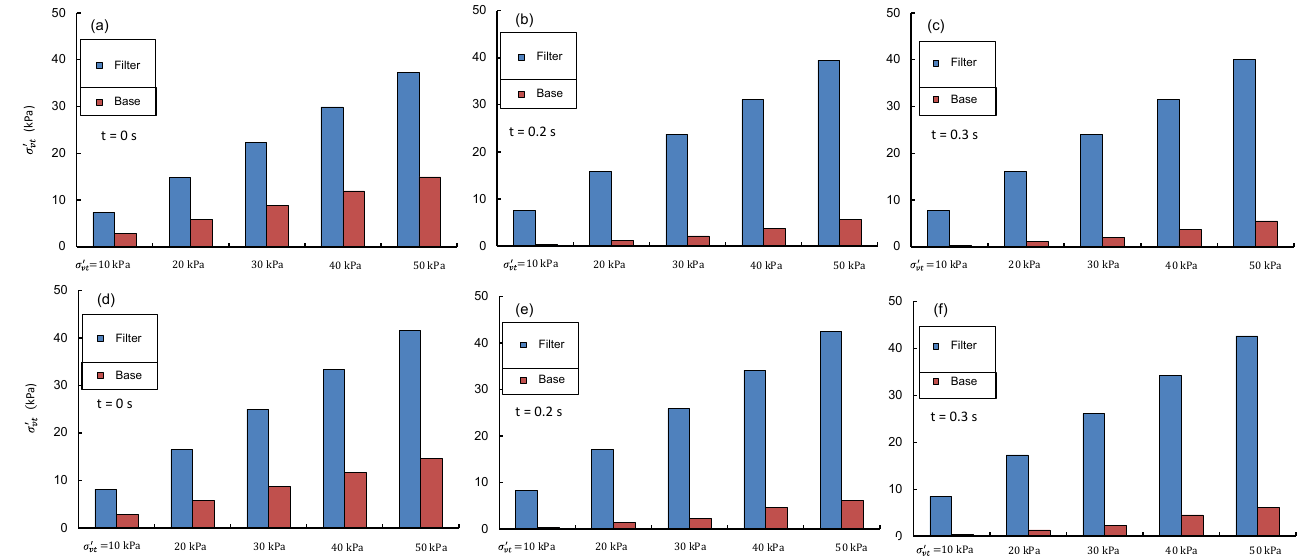
Figure 3. Effective stress distributions in specimens; ( a ) NF1-NB at t = 0 s, ( b ) NF1-NB at t = 0.2 s, ( c ) NF1-NB at t = 0.3 s, ( d ) NF2-NB at t = 0 s, ( e ) NF2-NB at t = 0.2 s, and ( f ) NF2-NB at t = 0.3 s.